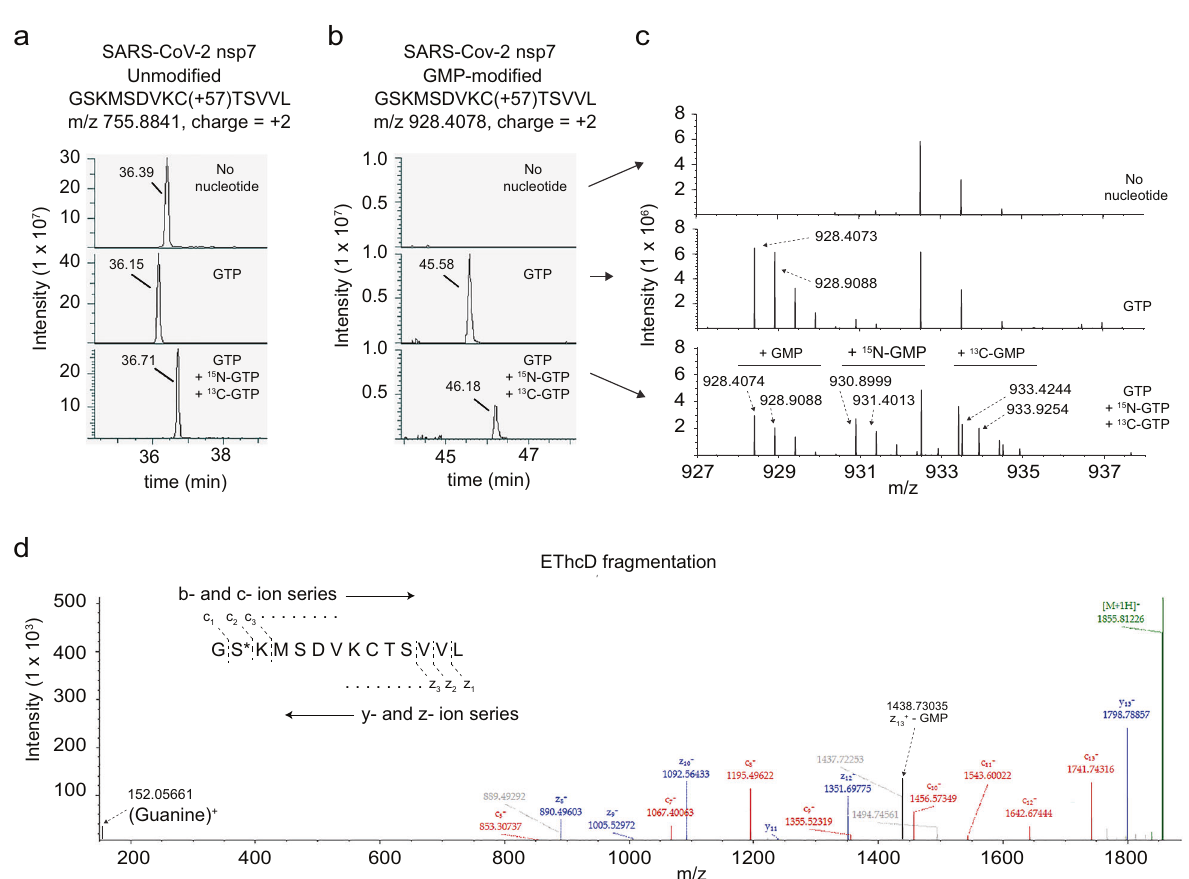
Fig. 2 Detection of a GMP-modi fi ed SARS-CoV-2 peptide using LC – MS/MS. a Extracted ion chromatograms at the indicated mass-to-charge ratio (m/z) ( + / − 5 parts per million) show precursor peptide MS signals versus retention time for the unmodi fi ed SARS-CoV-2 nsp7 peptide 1 – 14 with a charge of + 2. Signals are shown for samples that were incubated without GTP (no nucleotide), with GTP, or with a mixture of GTP, 15 N-GTP and 13 C-GTP. b MS signals at the m/z of 928.4078 for these same samples. This mass corresponds to the GMP-modi fi ed version of the same peptide with a charge state of + 2. c The average mass spectrum across these peaks is shown from the m/z range of 927 – 938 in order to visualize the presence or absence of the isotopic mass envelops for the GMP-labeled peptide and the corresponding 15 N- and 13 C-labeled GMP peptides. For the unlabeled sample, average mass spectrum for retention times of ~45.68 – 45.78 is shown. d The top-scoring EThcD peptide spectrum match for same GMP-labeled peptide is shown with labeling of main fragment ions. Ion series fragmentation for this peptide is illustrated with the asterisk indicating the GMP-modi fi cation site. Red, blue and green coloring indicate c- fragment ions, z- and y- fragment ions, and precursor ions, respectively. The GMP-modi fi ed SARS-CoV-2 nsp7 peptide was observed in two separate experiments each with two technical